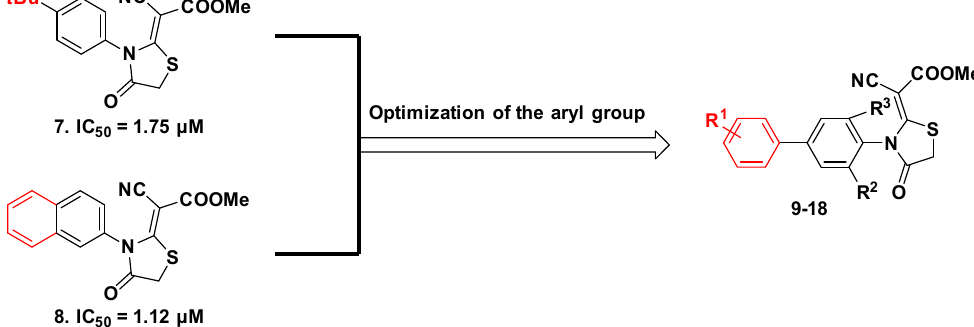
Figure 4. Molecular design strategies of 4-thiazolidinones with biphenyl as h DHODH inhibitors.